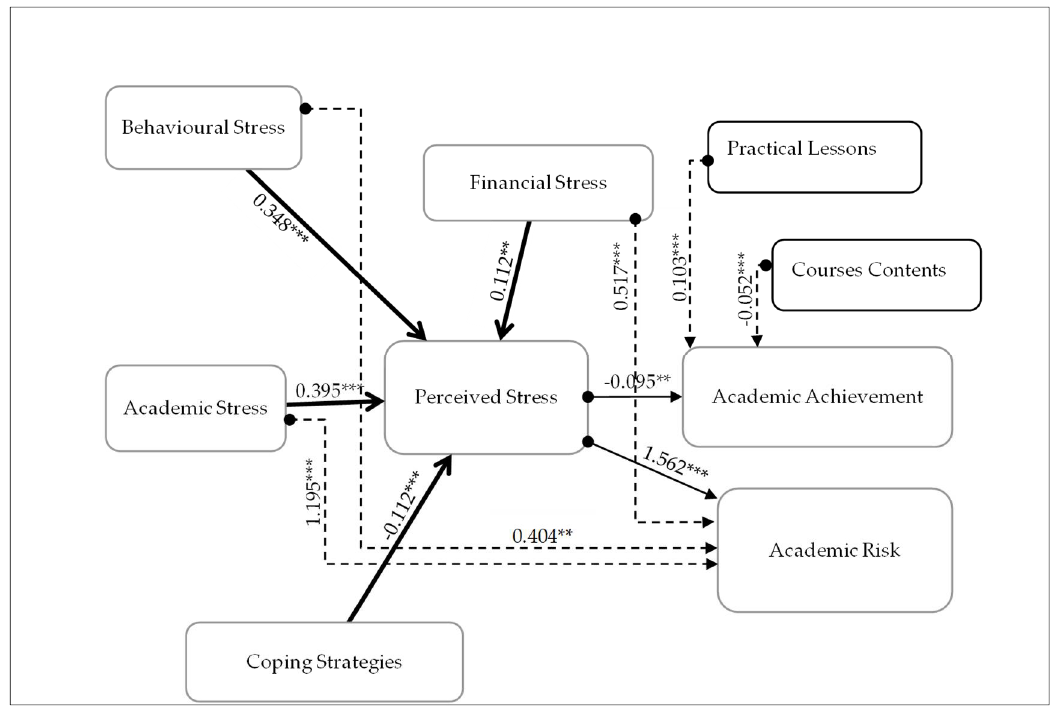
Figure 7. Final theoretical framework. *** p < 0.01, ** p < 0.05.